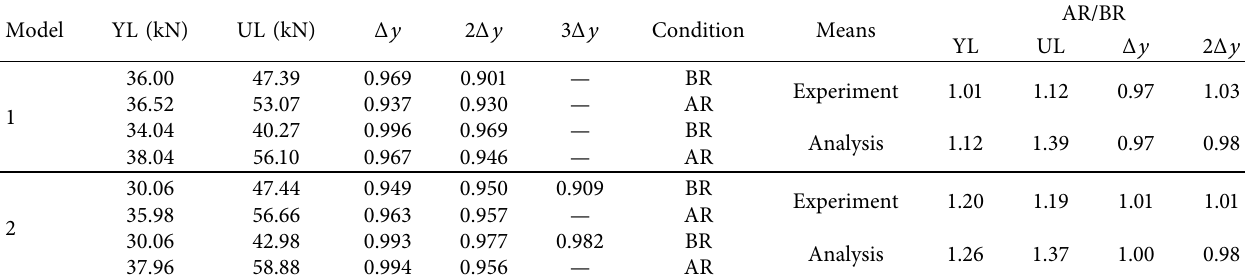
Table 7: Comparison of bearing capacity reduction coefficient of joints.